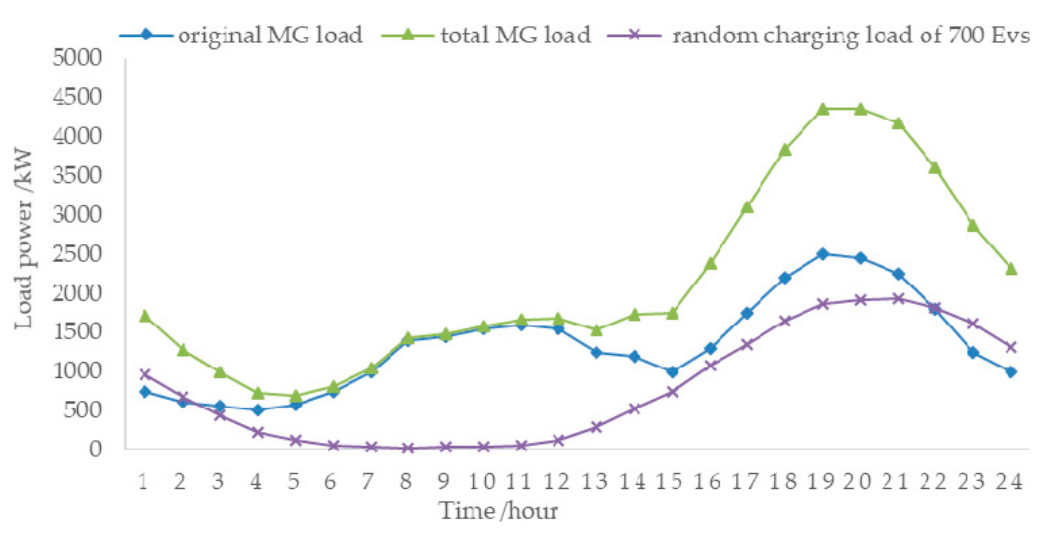
Figure 12. Output of each unit at the source-load-grid level.